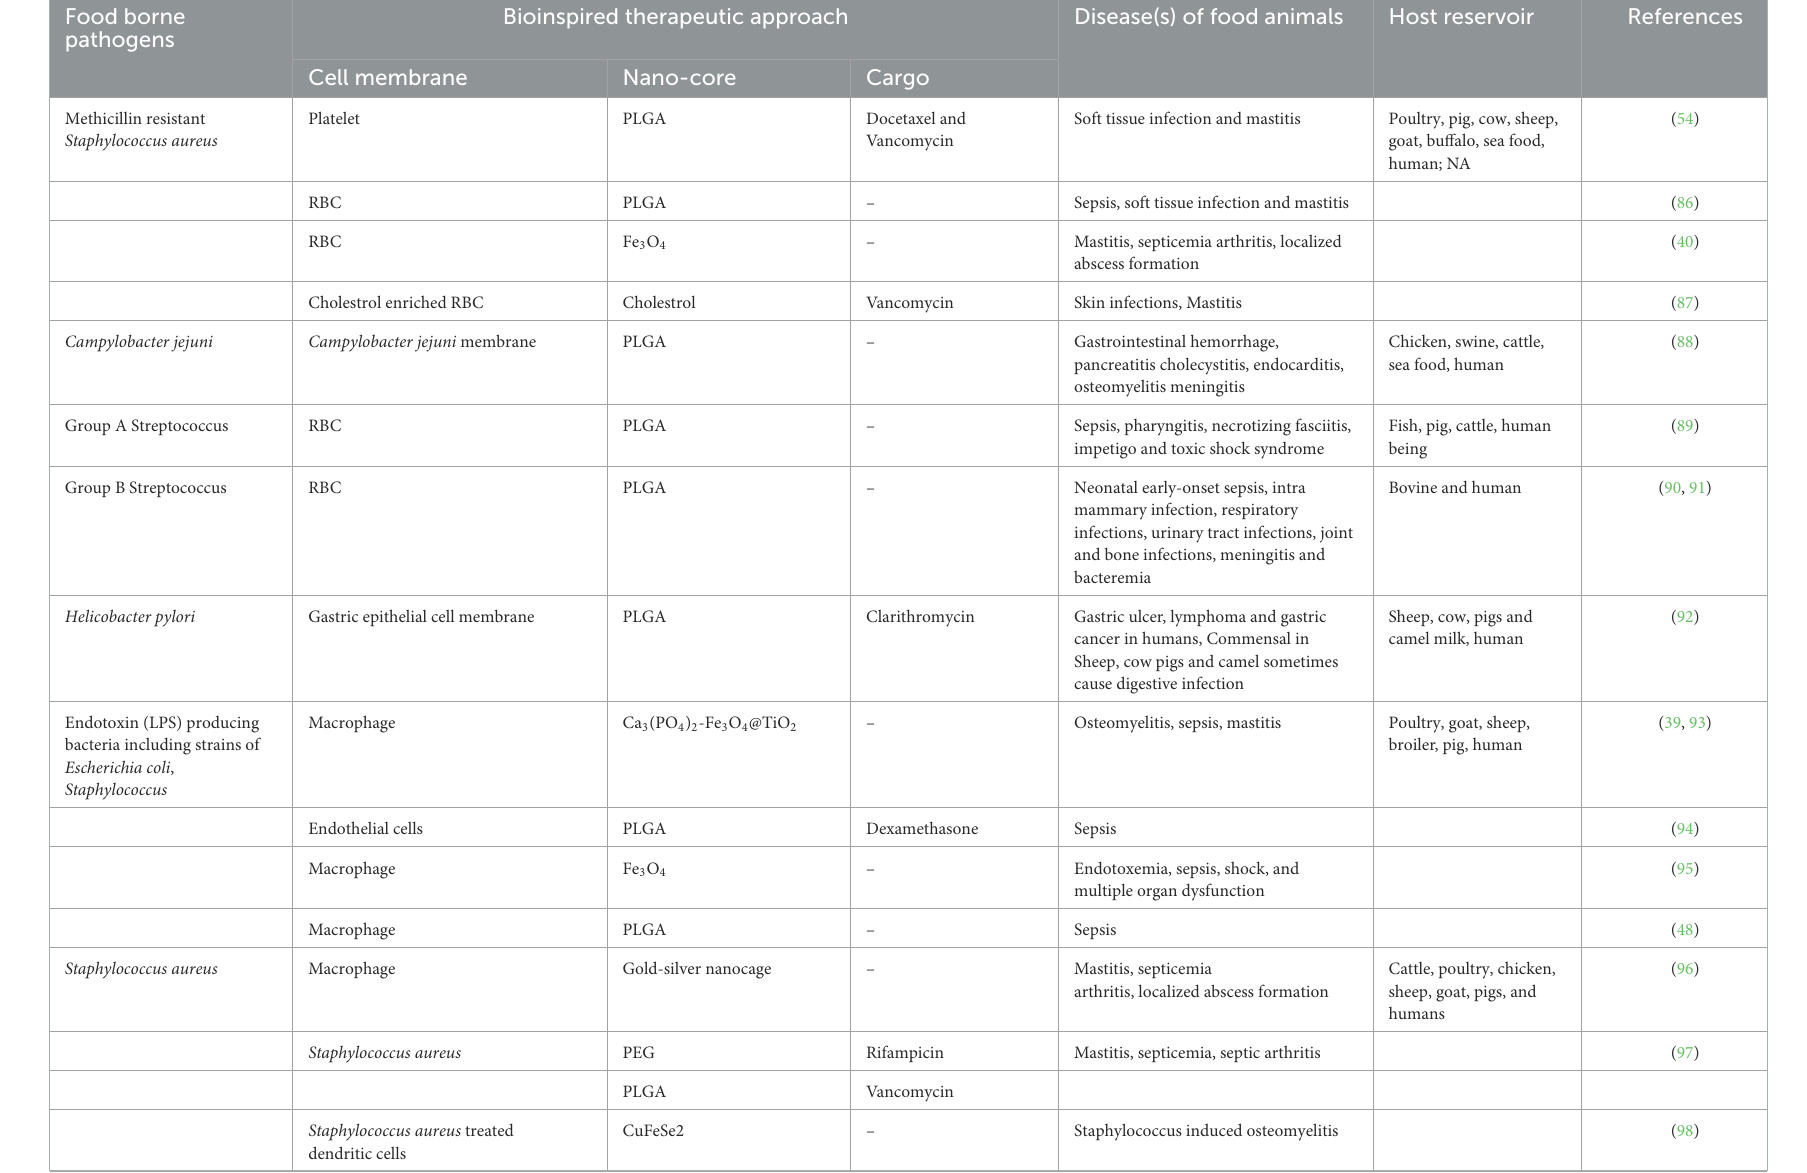
TABLE 1 Antibacterial cell membrane-coated nanoparticles against the food borne